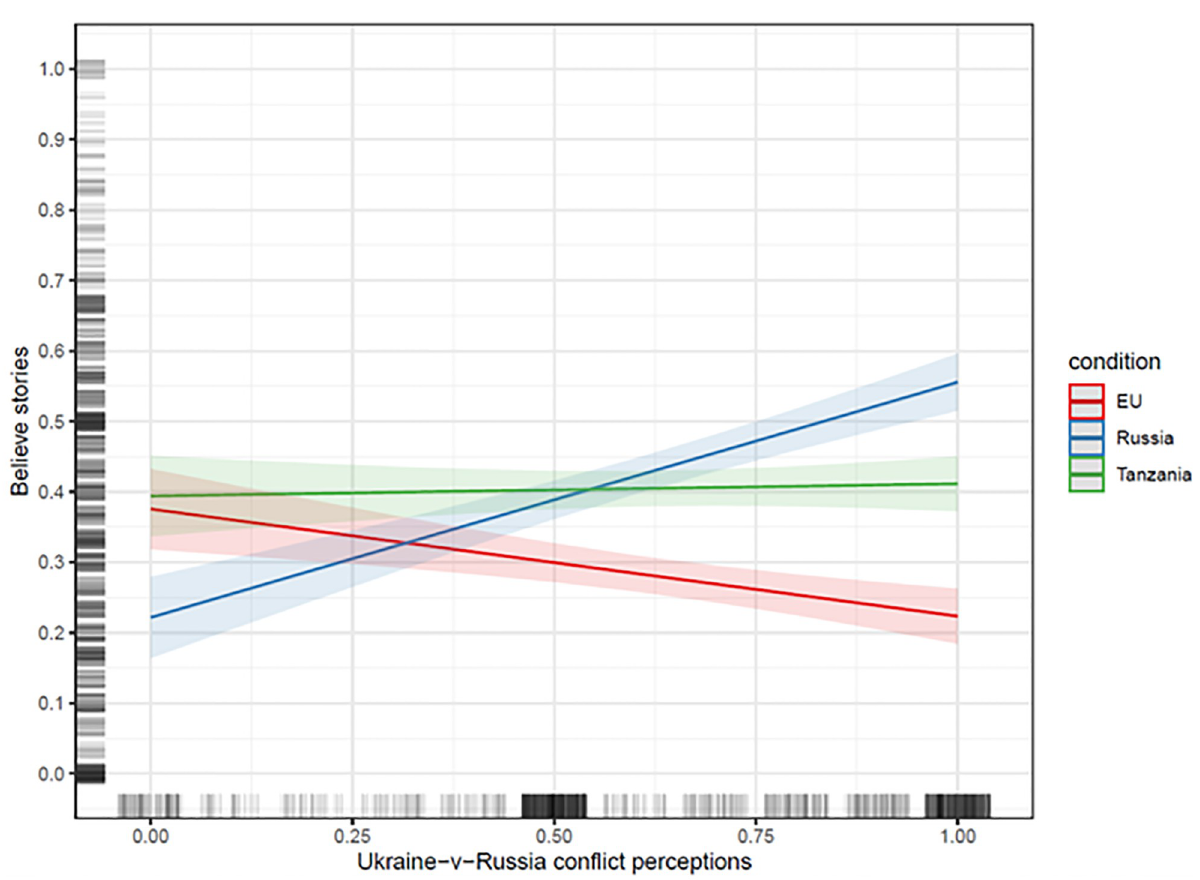
Fig 2. Predicted values of believing the false news stories with 95% confidence intervals by treatment condition -- the EU (red), Russia (blue) and Tanzania (green) -- across the range of conflict perceptions between Ukraine and Russia. Predicted values are based on OLS regression models with the covariates set to their mean (for continuous variables) or median (for categorical variables) values. The vertical and horizontal lines to the left and at the bottom present the jittered distribution of the dependent variable and conflict perceptions, respectively. Conflict perceptions between Ukraine and Russia range from 0 to 1, with higher values indicating stronger perceptions of conflict. The dependent variable ranges from 0 to 1, with higher values indicating stronger beliefs the stories are true. The model adjusts for age, gender, educational level, employment status, political interest, identification with Ukraine/Russia/ the EU, perceptions of power asymmetries, perception of conflict between Russia and the EU, as well as the interactions between Ukraine-Russia conflict perceptions and these